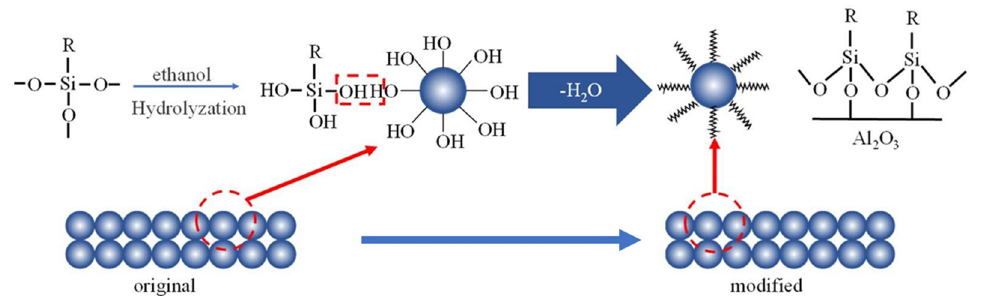
Figure 1. Schematic diagram of the hydrophobically modification process .